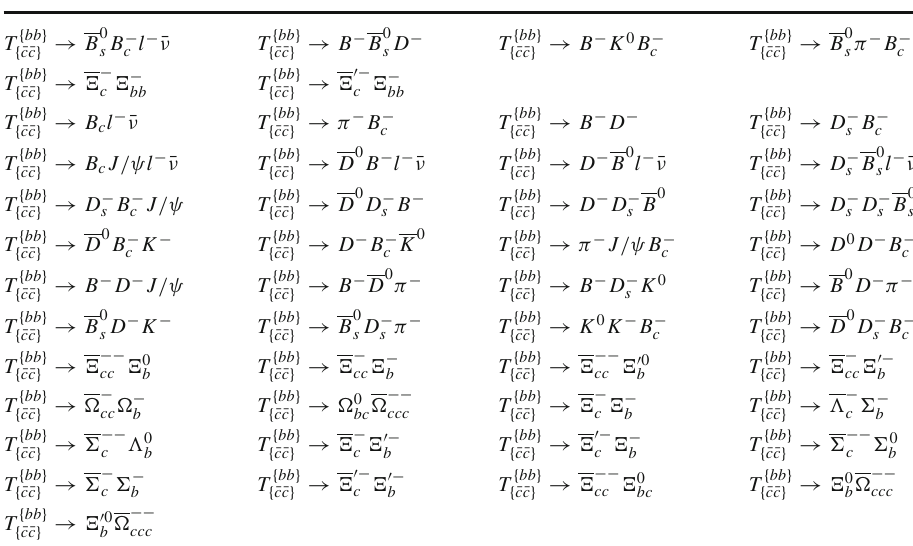
Table 12 Cabibbo allowed { bb } ¯ c -quark and b-quark T {¯ c ¯ c } decays